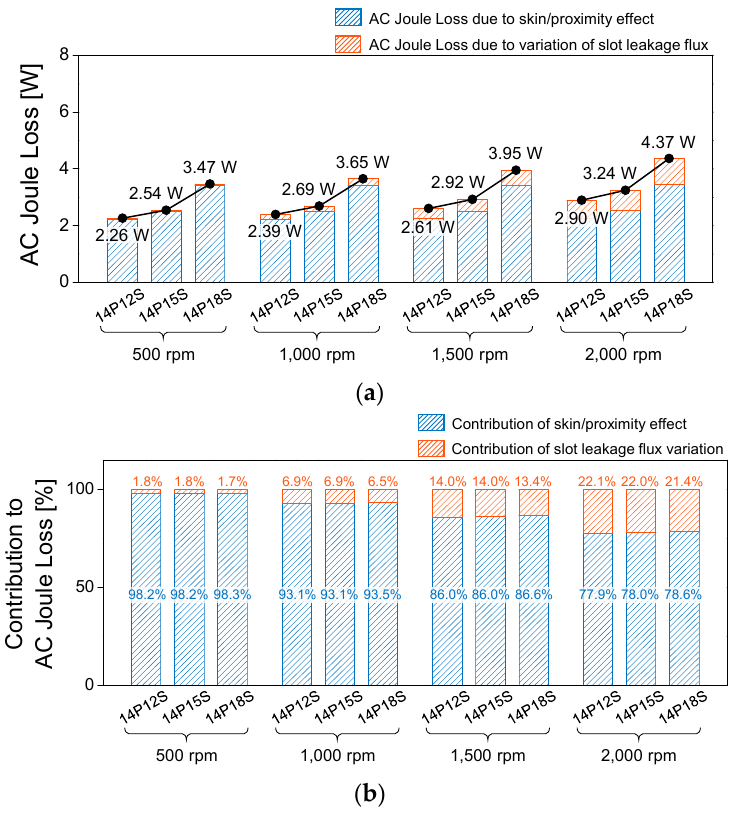
Figure 8. Effect of stator slots on AC Joule loss. ( a ) AC Joule loss and ( b ) contribution to AC Joule loss by each cause at various numbers of poles and rotational speeds.